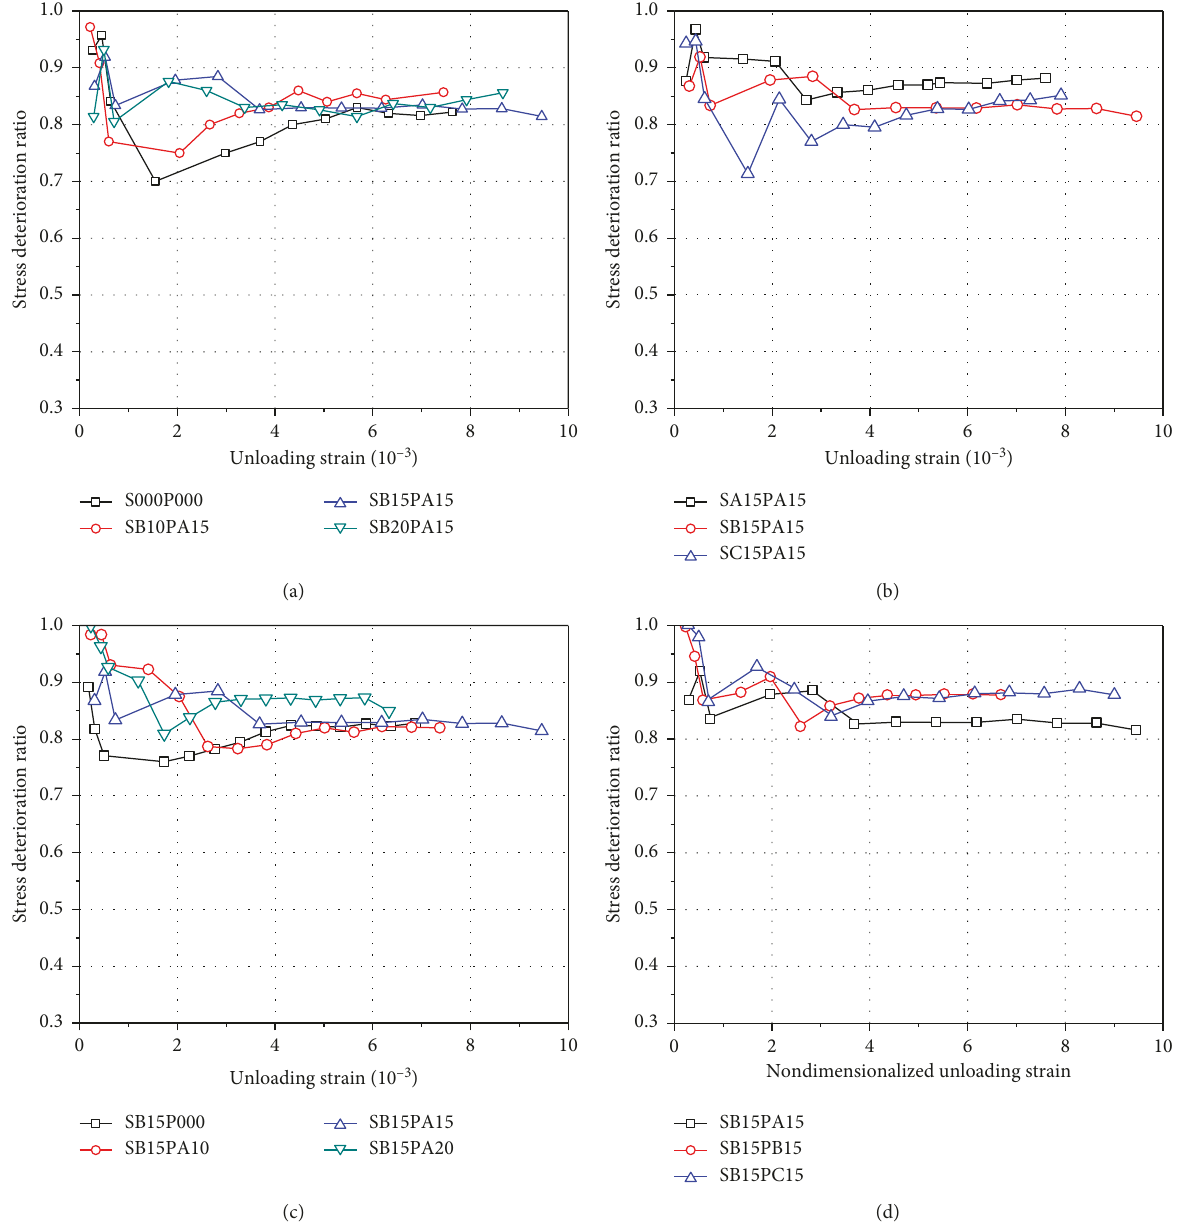
Figure 12: Relations between stress deterioration ratio and envelope unloading strain. (a) Effect of steel fiber volume fraction; (b) effect of steel fiber aspect ratio; (c) effect of polypropylene fiber volume fraction; and (d) effect of polypropylene fiber aspect